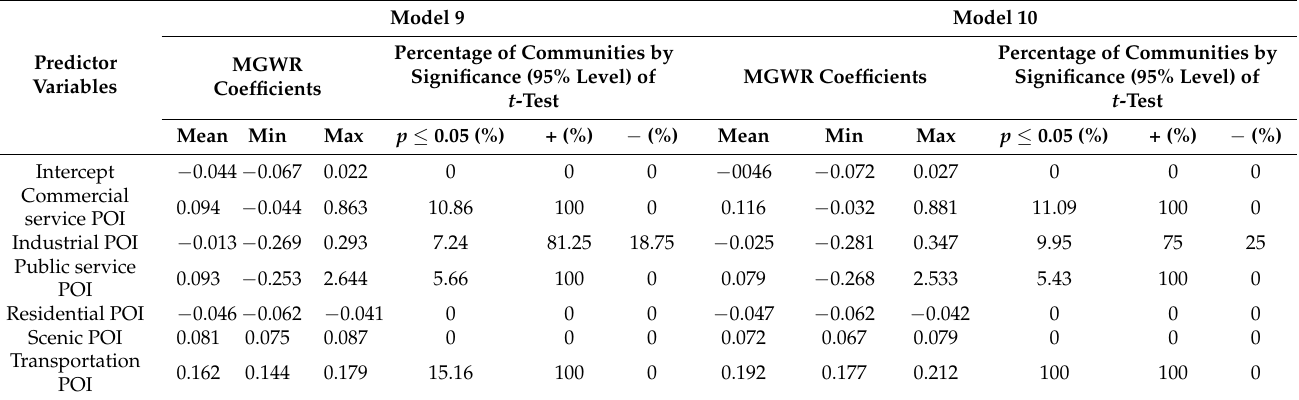
Table 6. Summary statistics for the MGWR coefficient